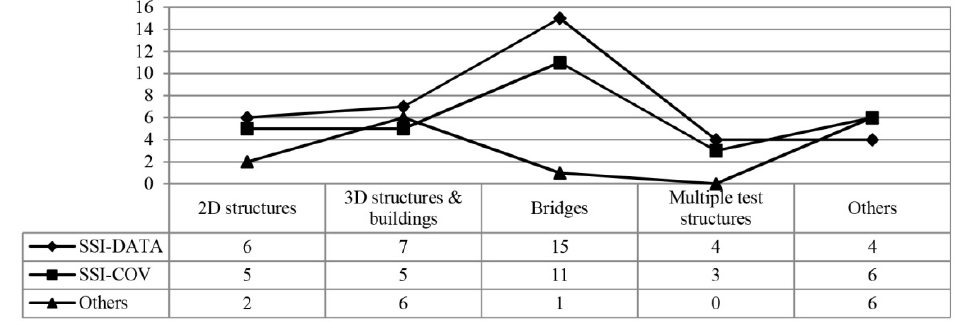
Figure 5. The distribution of the paper by the test structures and the applied subspace system identification methods.